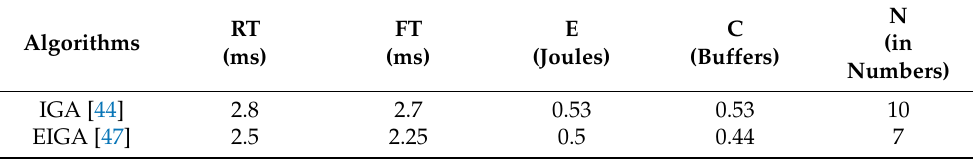
Table 3. Comparison between IGA and